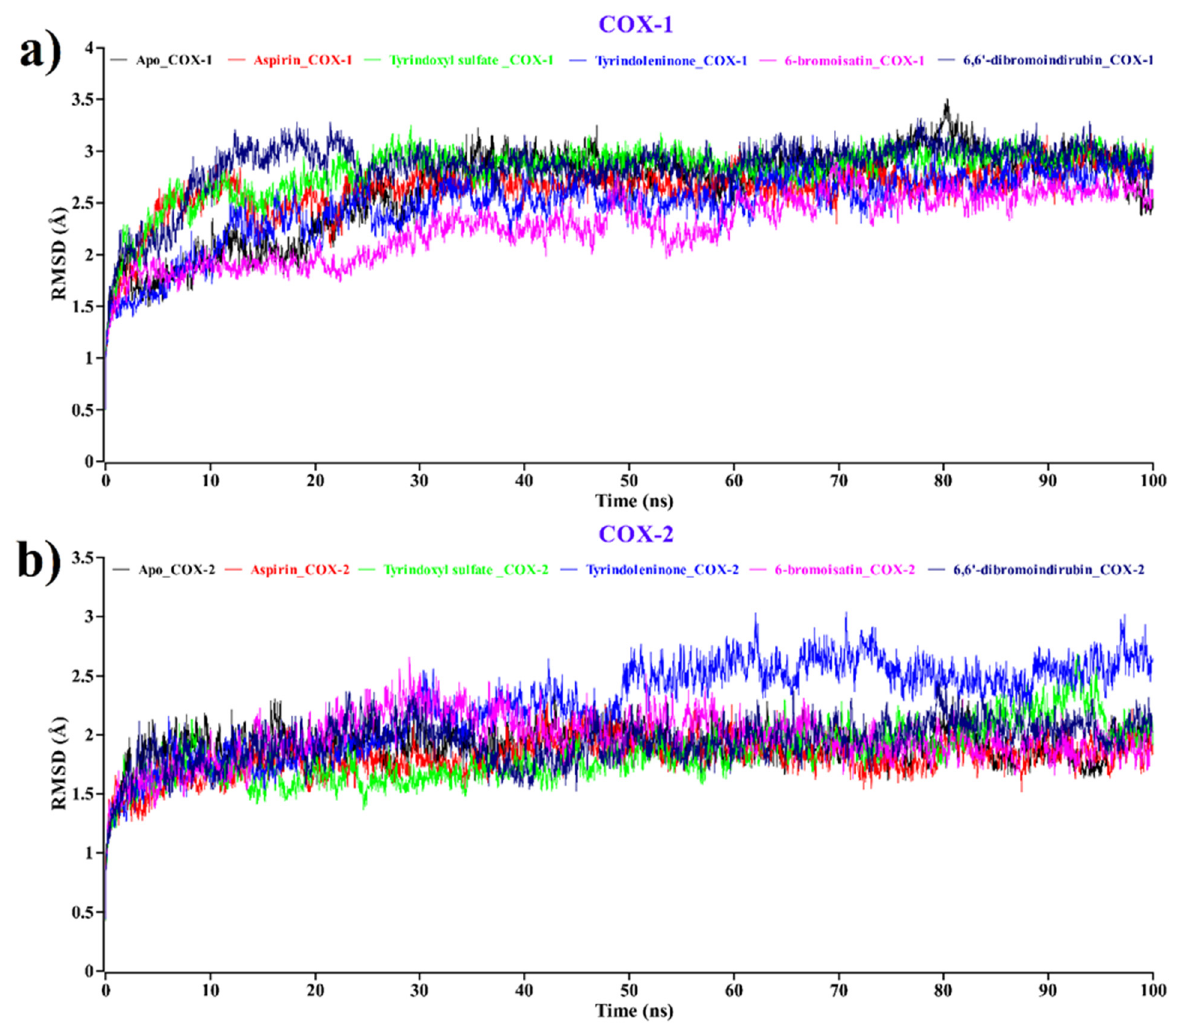
Figure 4. Time evolution of root mean square deviation (RMSD) for the protein of each docked complex for ( a ) COX-1 and ( b ) COX-2. Complexes: Black—apo protein, red—aspirin, green—tyrindoxyl sulfate, blue—tyrindoleninone, magenta—6- bromoisatin, navy blue—6,6’-dibromoindirubin.